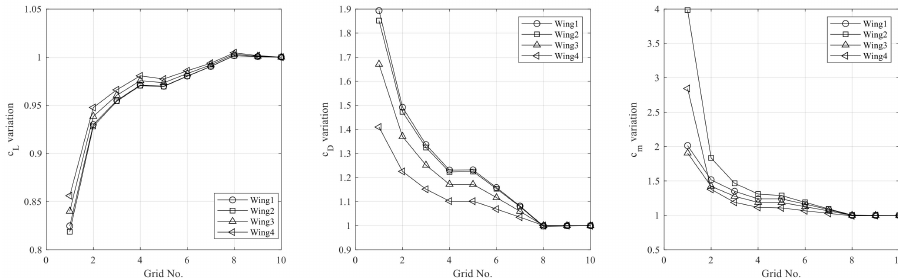
Figure 7. Convergence of aerodynamic coe ffi cients with grid refinement level.